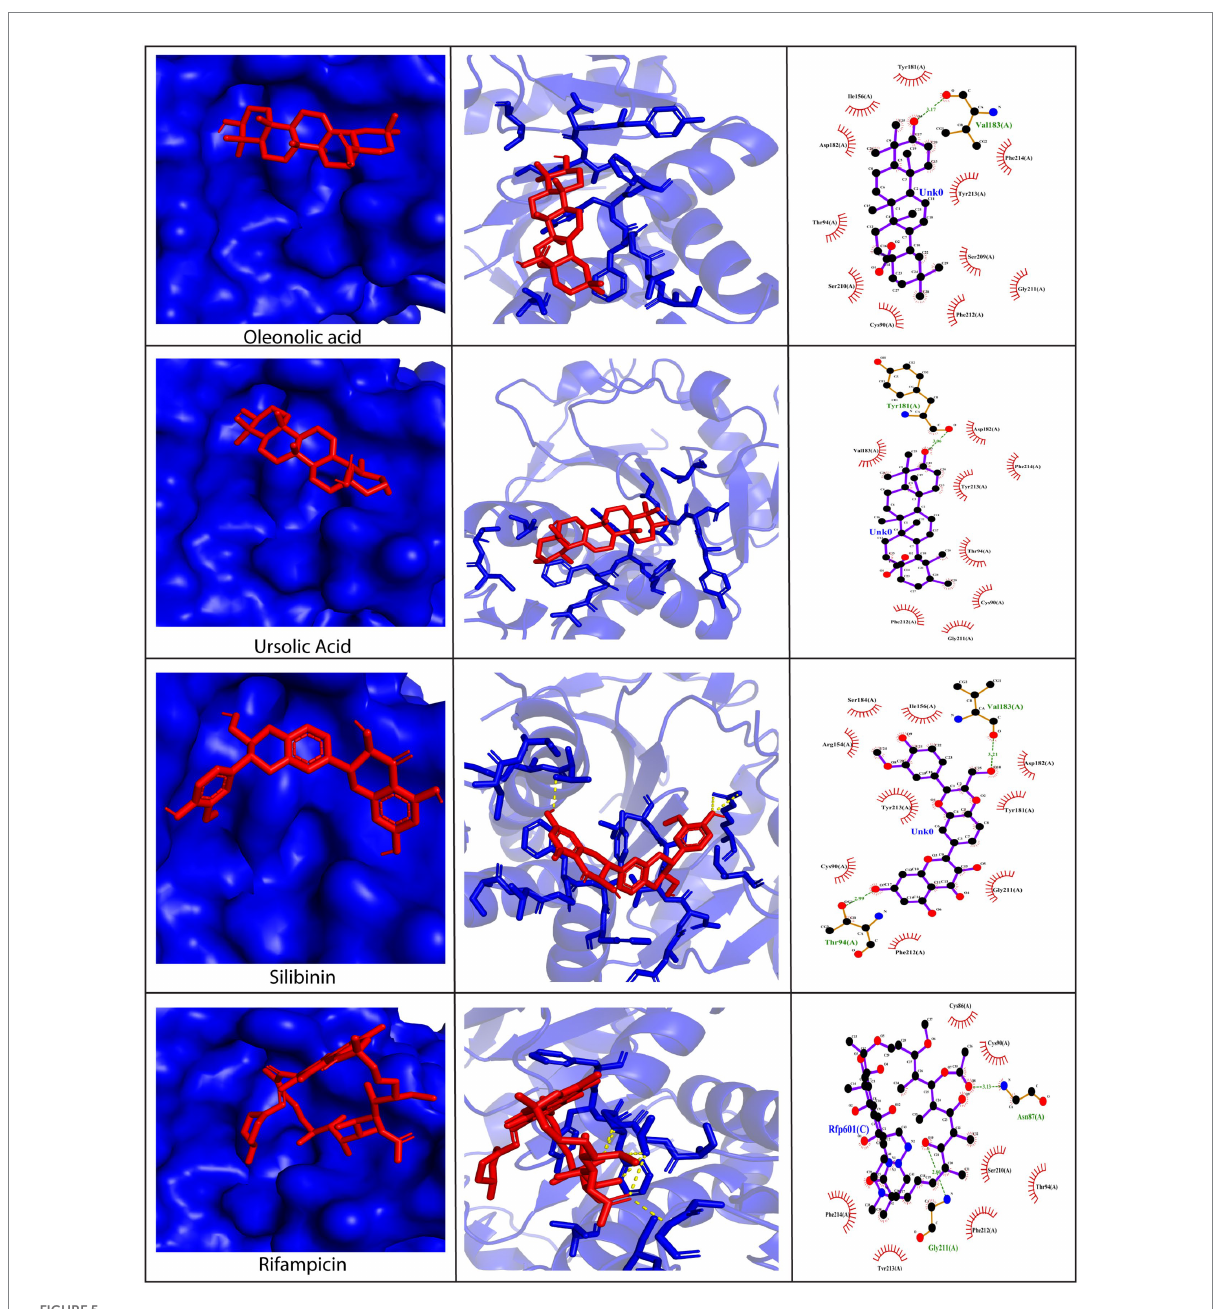
FIGURE 5 Molecular docking of silibinin, oleanolic acid, and ursolic acid against the H3 protein (PDB ID: 5EJ0). Left Panel: Visualization of the binding position of the ligand within the protein cavity. Central Panel: Ribbon diagram showing the docked complex. Ligands are shown in red. Right Panel: 2D diagram representing the interactions between phytochemicals and H3 protein generated by LigPlot. Dashed lines illustrate hydrogen bonding and the red arcs represent hydrophobic interactions. Rifampicin has been used as a control. Docking was performed via AutoDock Vina (Version 1.5.7) and the 3D structures were visualized using PyMol